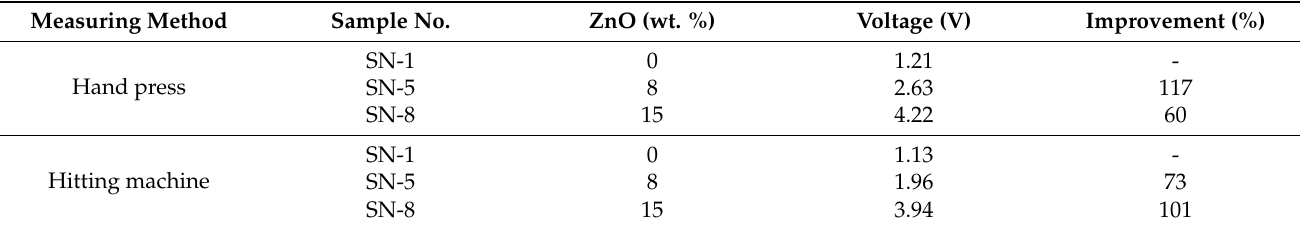
Table 2. Electrical response of prepared